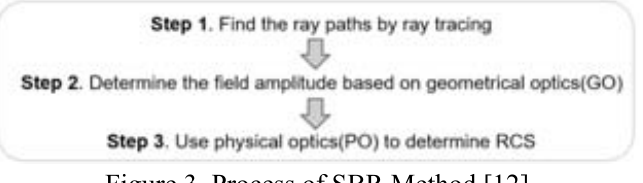
Figure 3 . Process of SBR Method [12]